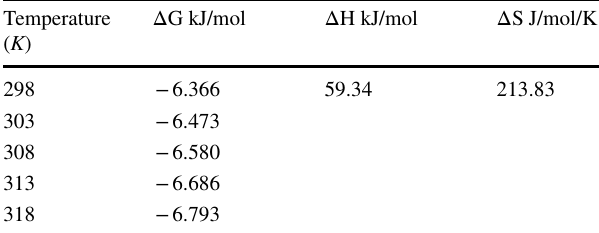
Table 2 Values of thermodynamic parameters for As(III) adsorption by